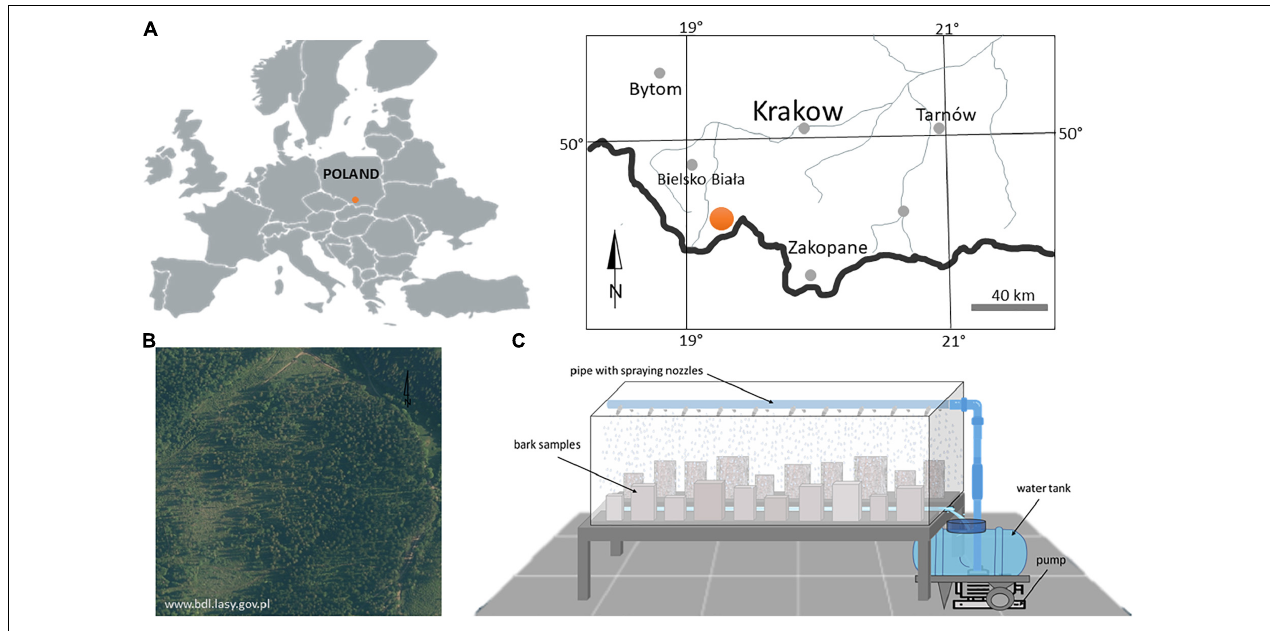
FIGURE 1 | Location of the study area (A) with a view of the stand where bark samples were collected (B) and rainfall simulator construction (C)